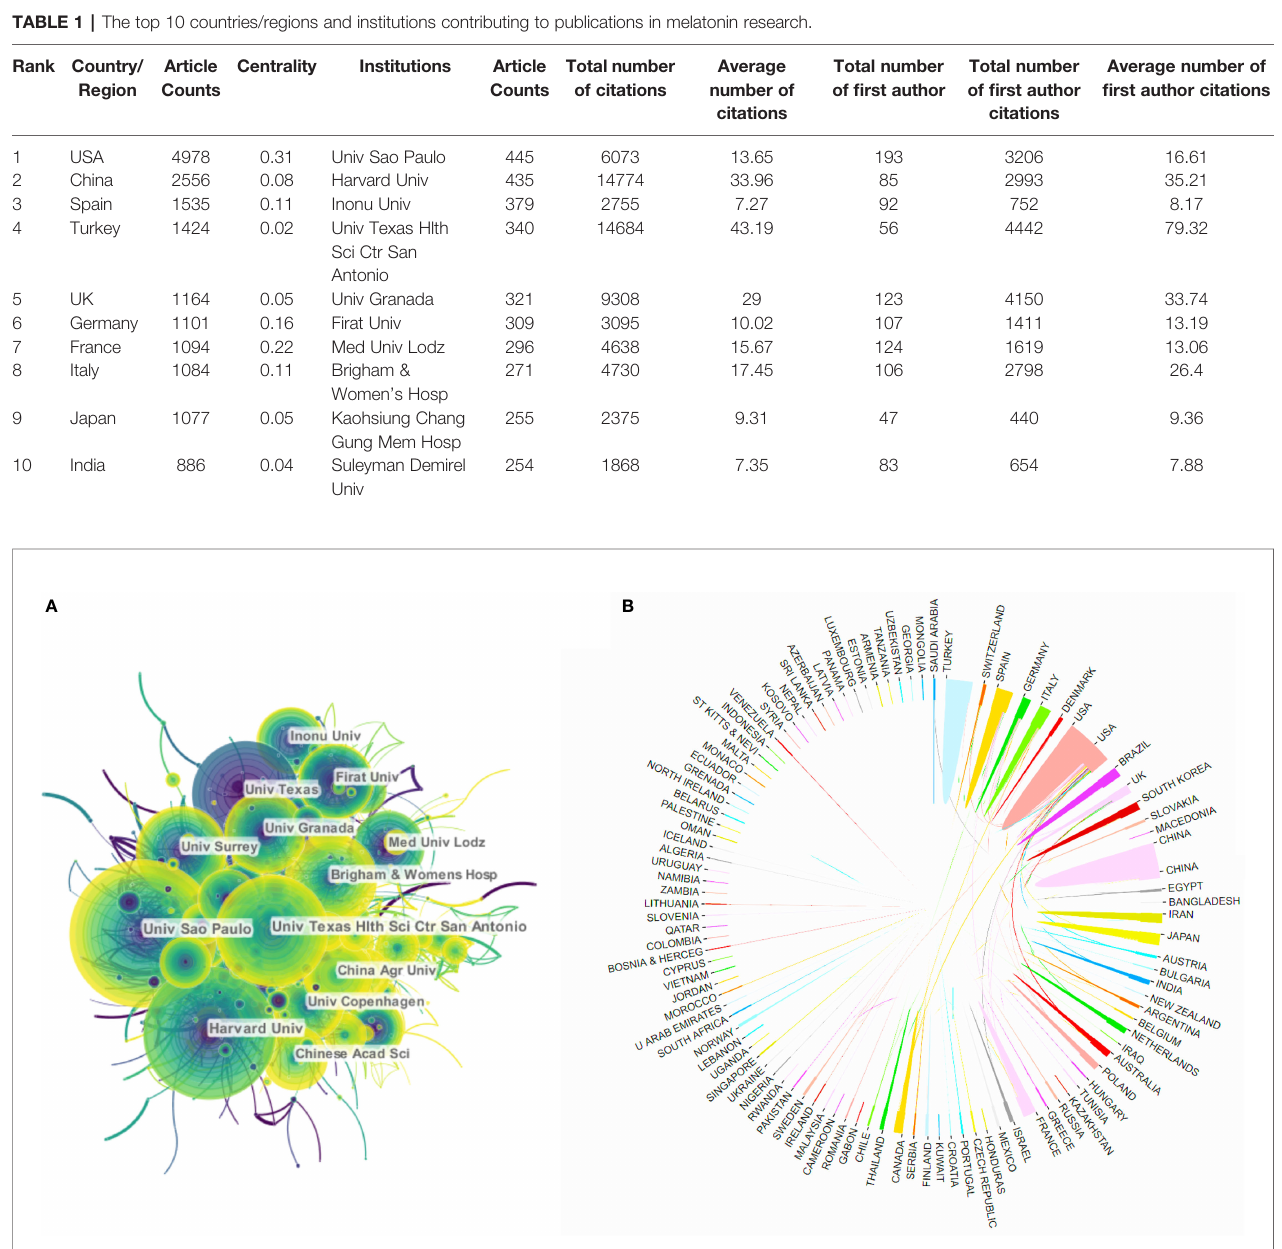
FIGURE 3 | Cooperation among different countries and institutions. (A) Density map of cooperation among institutions. (B) Cooperation among different countries.